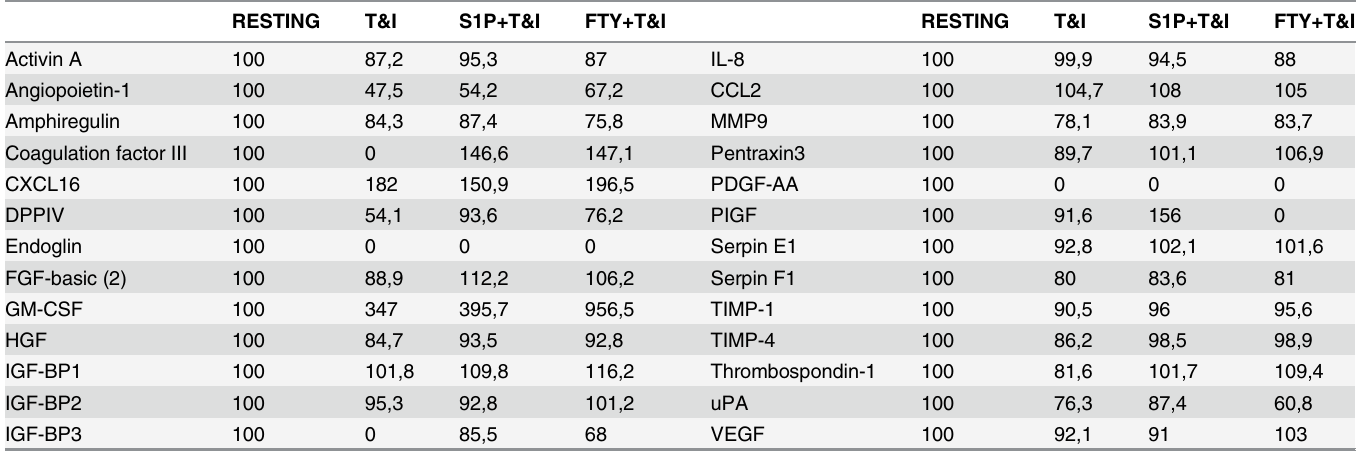
Table 1. Summary of the principal factors released by hAST into the media after T&I exposure either alone or in combination with S1P or FTY as determined by a limited Proteome Profiler Human Angiogenesis Array (R&D Systems). For each factor, densitometric analysis of band intensity was carried out with the Image J Software developed by NIH. Values are indicated as percent variation over resting